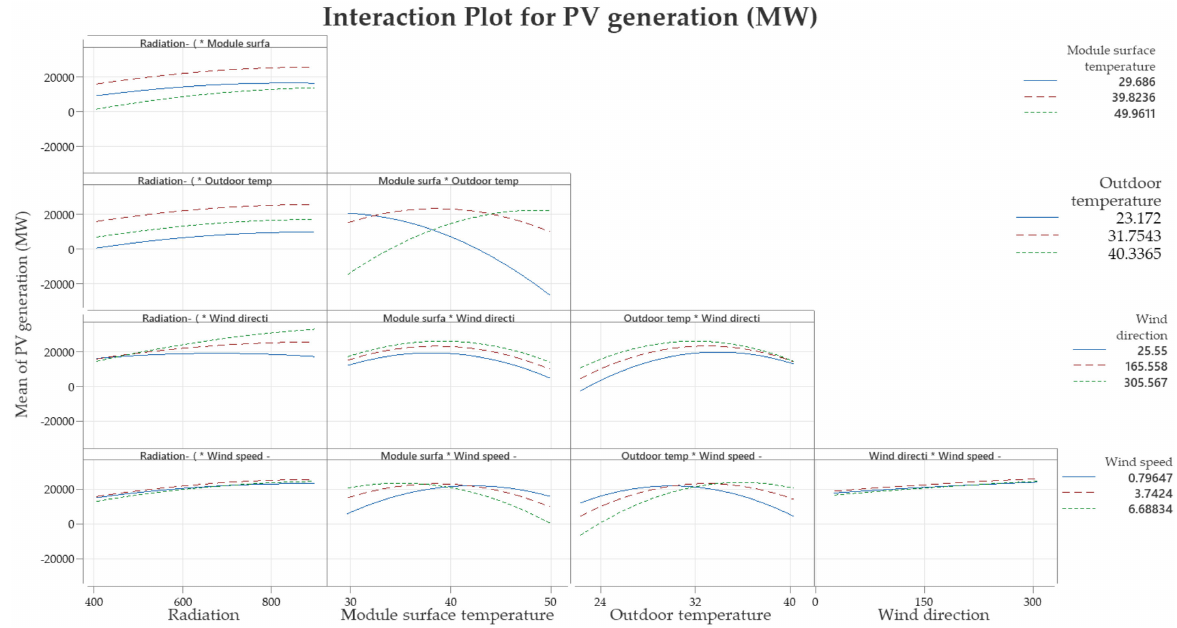
Figure 17. The plots of independent parameter interaction for solar PV